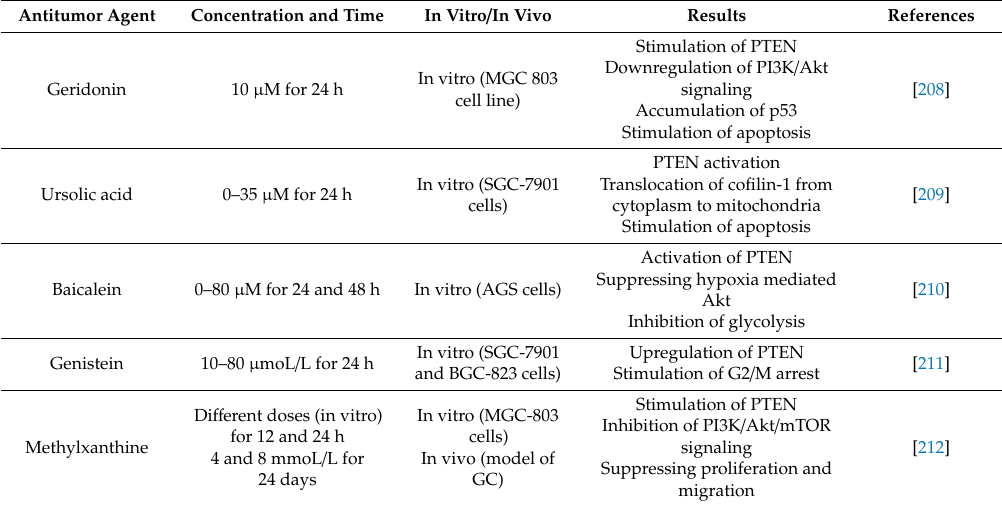
Table 3. Antitumor compounds targeting PTEN in GC